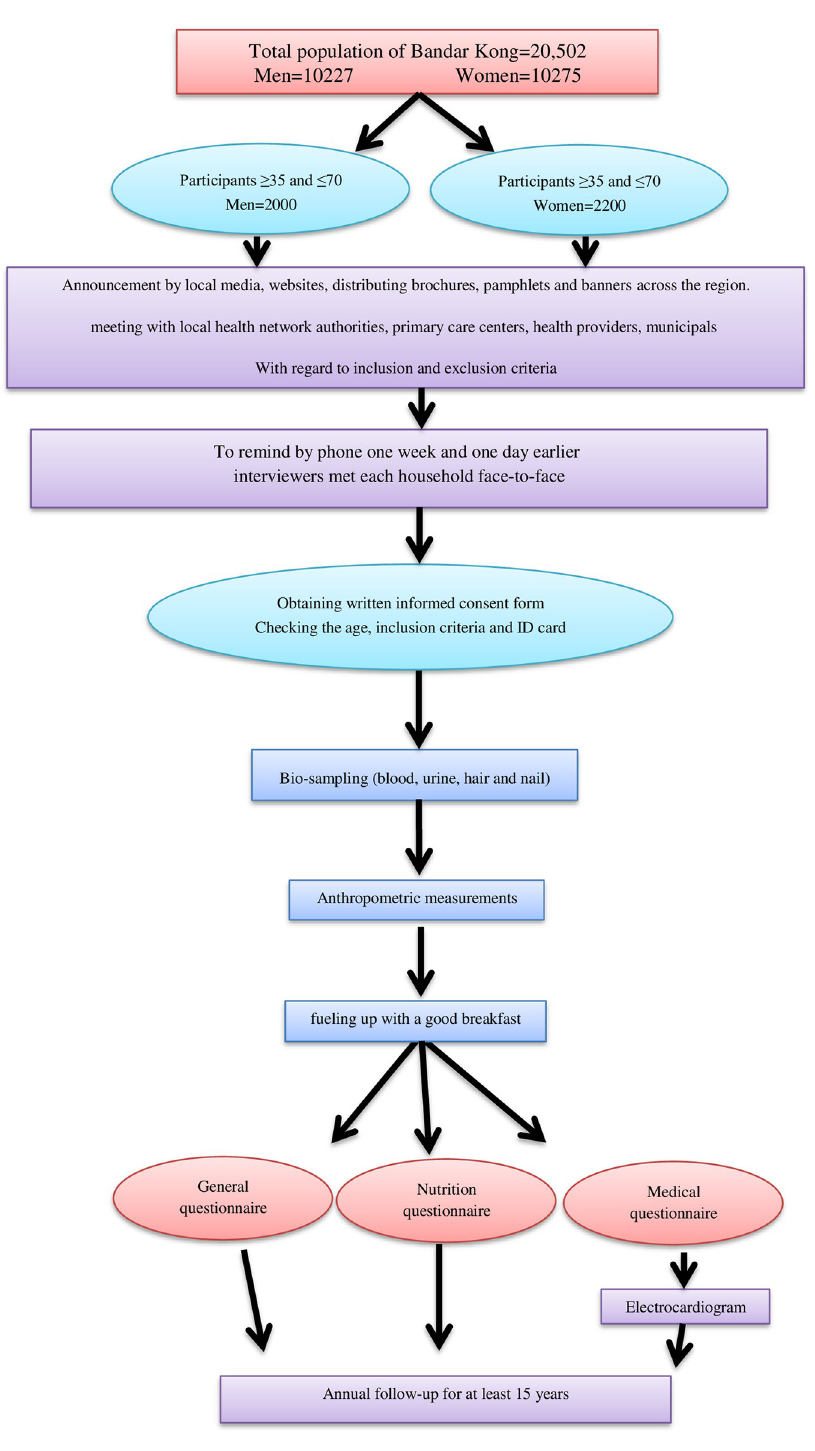
Fig 2. The phases of the data collection process of Kong cohort study.